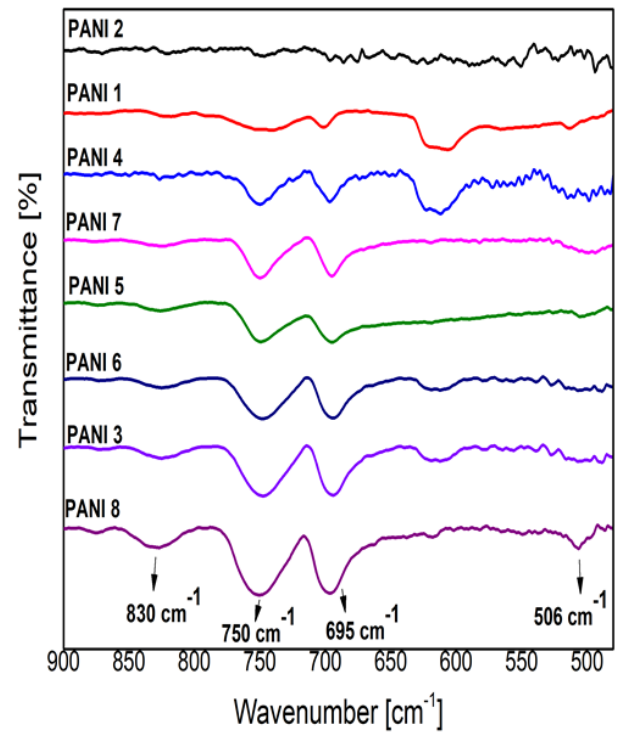
Figure 8. Details of PANI samples FTIR spectra in 900–450 cm −1 range.